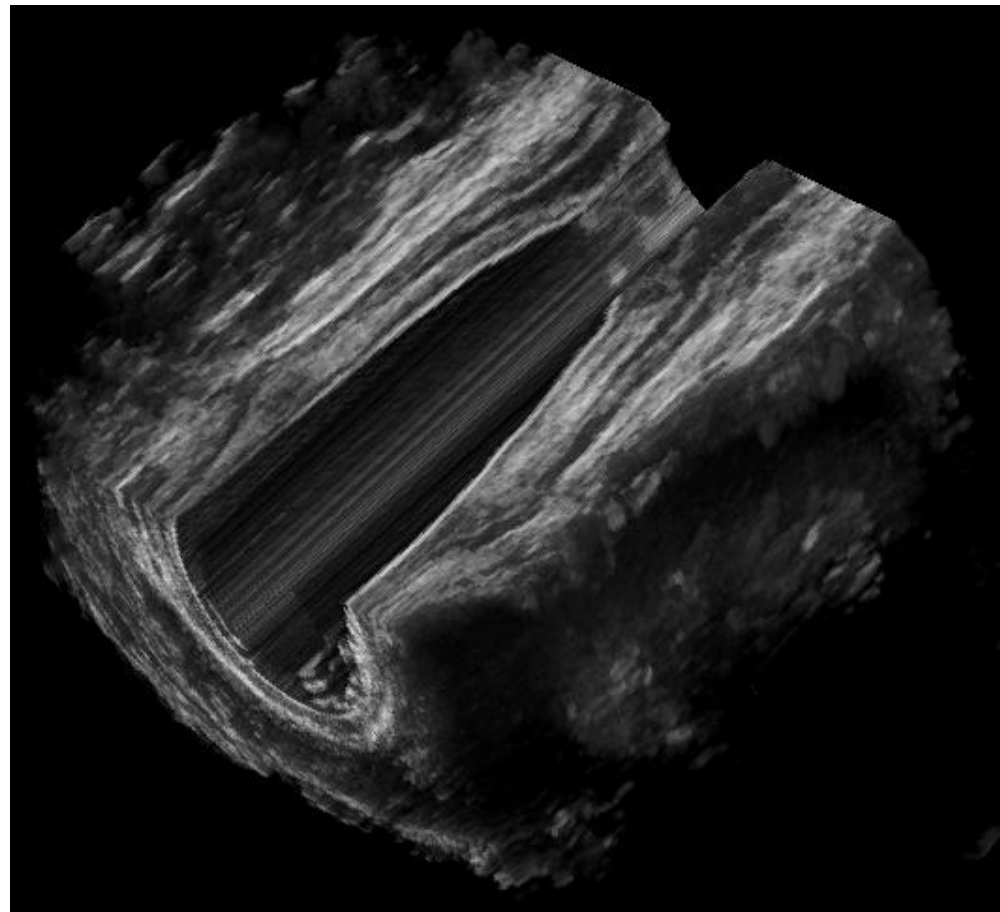
FIGURE 3 . Three-dimensional reconstruction of normal rectum using a rigid radial probe (Hitachi RW